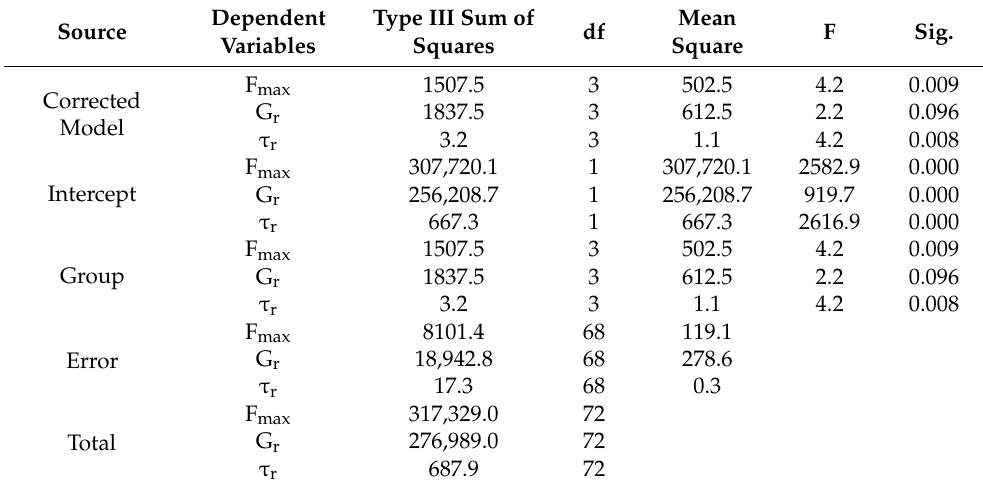
Table 5. ANOVA test results on the impact MOE of specimen lamellae on shear properties.